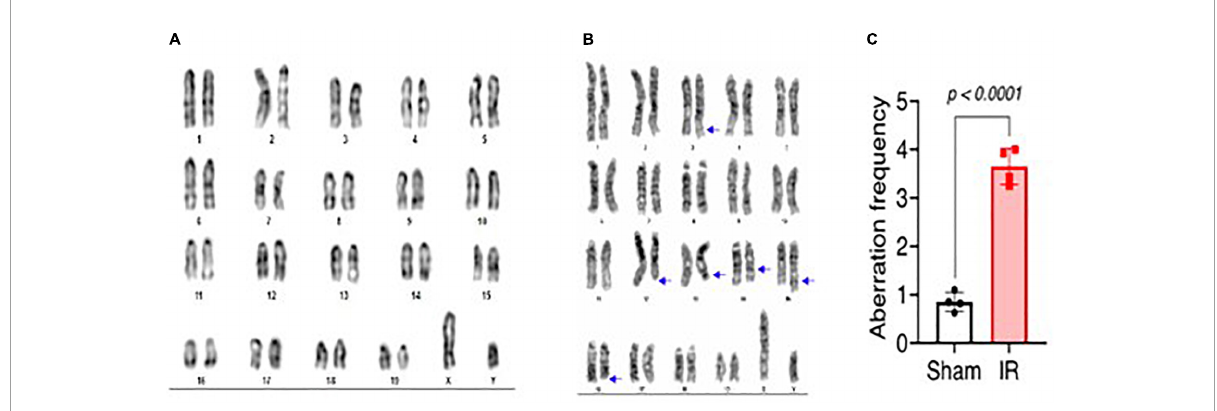
FIGURE4 Representative photomicrographs of G-banded chromosomes from (A) sham-irradiated and (B) irradiated mice (arrows indicate change in banding pattern). (C) Aberration frequency in sham-irradiated ( n = 4) and irradiated ( n = 4) mice as estimated by observing change in banding pattern of chromosomes following G-banding. Statistical uncertainty between the groups was determined by t